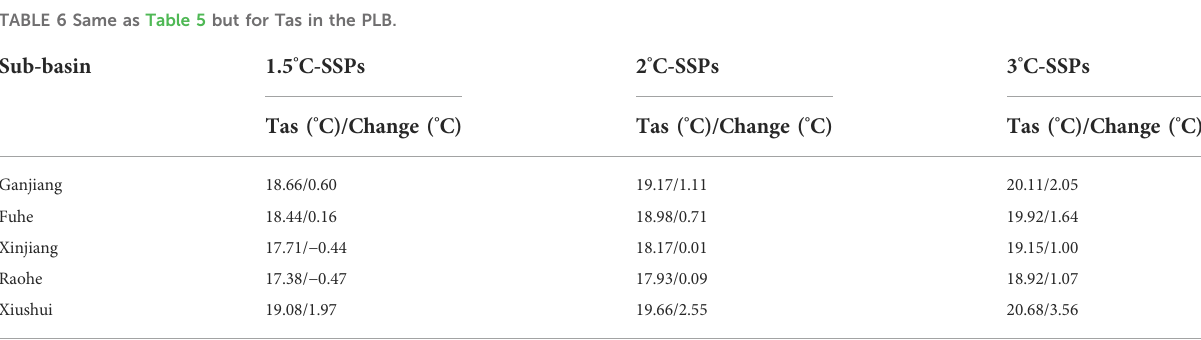
TABLE 6 Same as Table 5 but for Tas in the